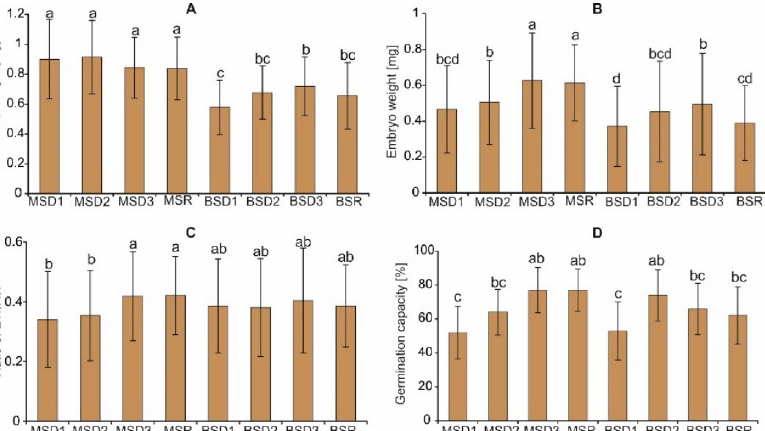
Figure 6. Comparison of A. montana seed characteristics ( A – C ) and germination capacity ( D ) of achenes from the four positions within the infructescence and the two positions of the infructescence on the plant. MS—main stem; BS—branch stem; D1–D3—achenes produced by disc florets; R—achenes produced by ray florets. Different lowercase letters indicate significant differences according to the Tukey test ( p < 0.05).